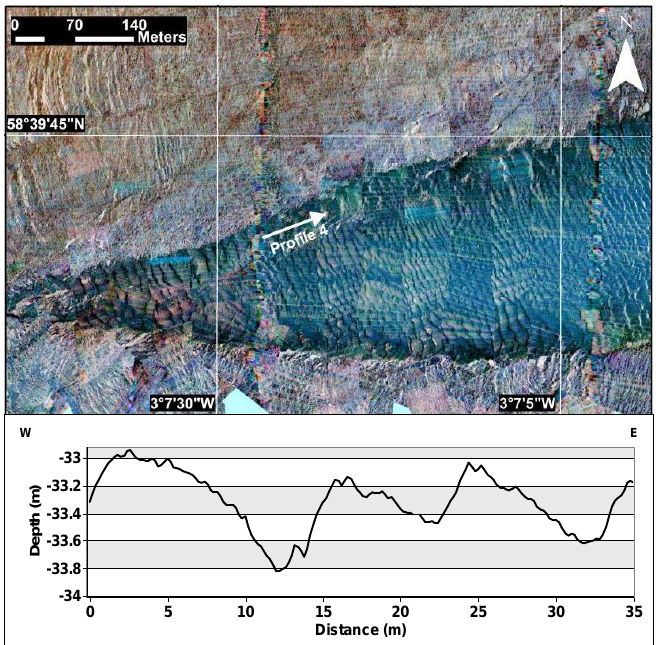
Figure 7. ( Top ) Profile from the multi-beam survey 2 (June 2016, ebb tide) taken on the wedge shaped sediment bank, arrow indicates start and stop of profile line; ( Bottom ) Profile 4 showing large sand dune formation on the northern edge of the wedge shaped sediment bank. Wavelengths of >10 m and amplitudes up to 1 m.